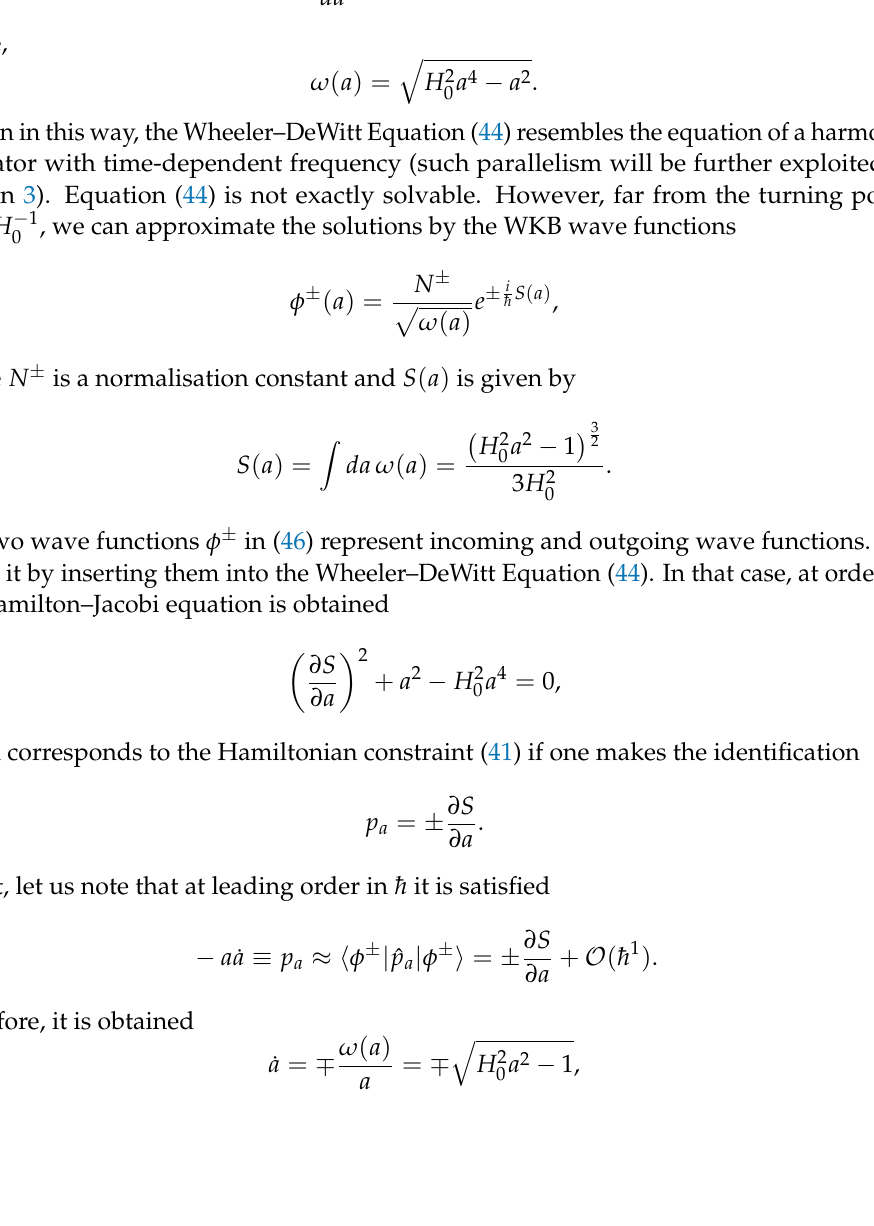
Figure 5. Left : the closed DeSitter spacetime describes a universe that starts shrinking from an infinite volume, bounces at the minimum value, a 0 = H − 1 Right : the value a 0 can be seen as a barrier where the incoming waves are reflected and converted into outgoing